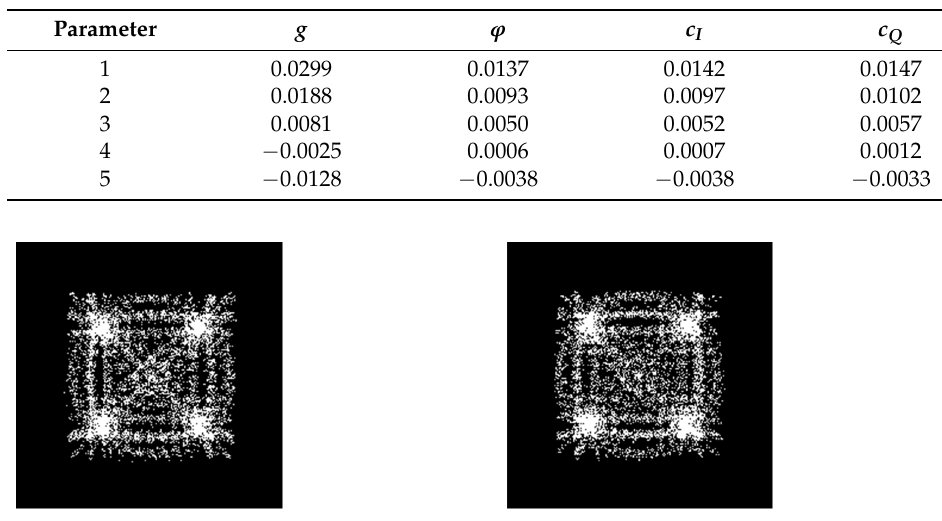
Table 3. Parameter settings for different specific emitters.